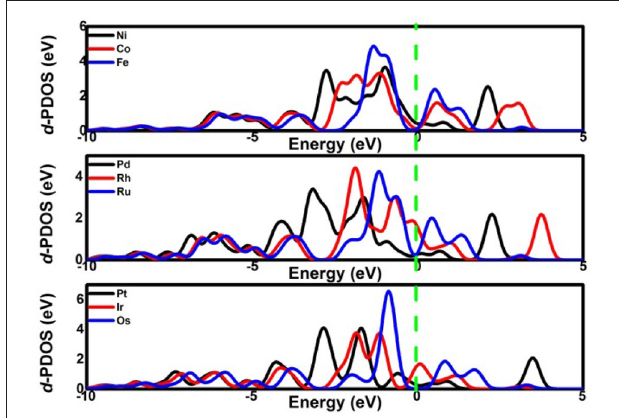
FIGURE 3 | The d -PDOS of the central TM atom.